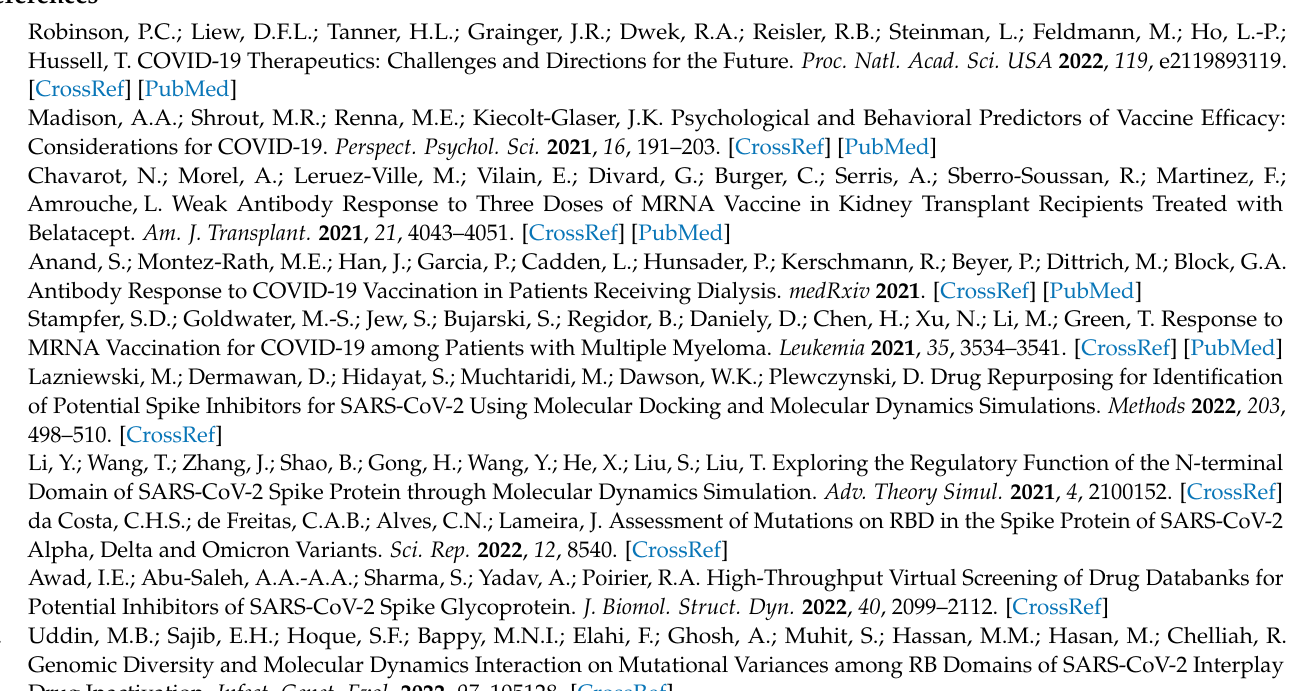
(b) GA-RBD complex, (c) OA5 -RBD complex, (d) MA4 -RBD complex, (E) UA2 -RBD complex. Black representation corresponds to replica 1, and red corresponds to replica 2; Figure S3: RMSF CA values: (a) RBD domain, (b) GA-RBD complex, (c) OA5-RBD complex, (d) MA4-RBD complex, (e) UA2-RBD complex. Black representation corresponds to replica 1, red corresponds to replica 2; Figure S4. Egan’s boiled egg diagram for all the studied compounds and the reference molecule. Neither molecule is a substrate of the P-gp; Table S1: secondary structure percentage from the final frame in the 100 ns molecular dynamics simulation; Table S2: RMSF values, in Å, for the region T470-F490 for both replicas; Table S3: structural and physicochemical properties for all the derivatives and the reference molecule. Table S4: pharmacokinetic and medicinal chemistry properties for all the studied compounds; Table S5: SMILES of the studied compounds and the reference compound (GA); Table S6: Molecular docking scores of the top selected compounds with N = 10 from 10 independently generated random seeds. The most favorable energy binding is shown for each